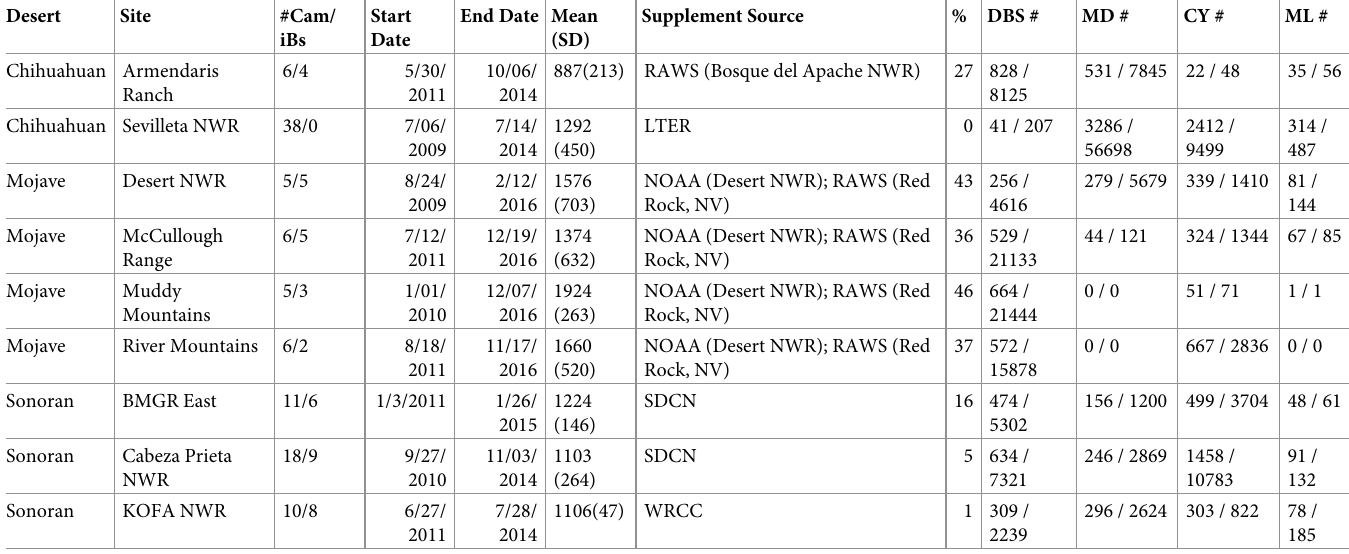
Table 1. Metadata of field camera operation. Columns indicate the number of trail cameras and iButtons (#Cam/iBs), duration of camera operation (with mean and standard deviation [days] across locations), sources used to supplement data (with percent of data supplemented [%]), the number of independent images analyzed by spe- cies, including the total number of images acquired (separated by a “/” [desert bighorn sheep (DBS), mule deer (MD), coyote (CY) and mountain lion (MY)]).